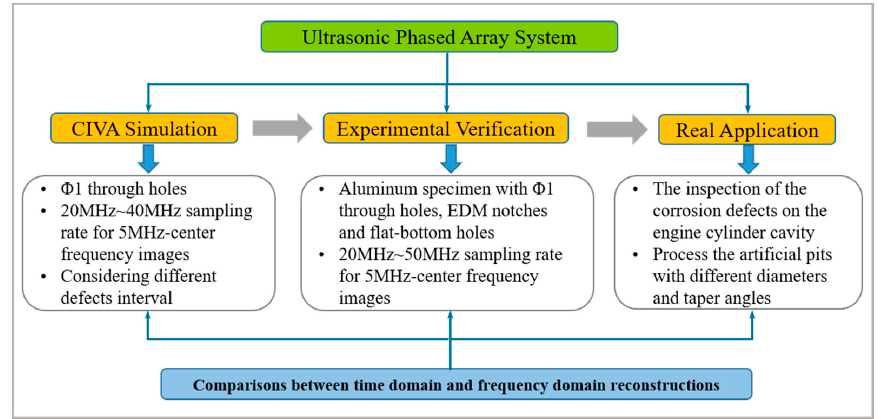
Figure 1. The simplified architecture of the proposed compressive sensing (CS)-based scheme.